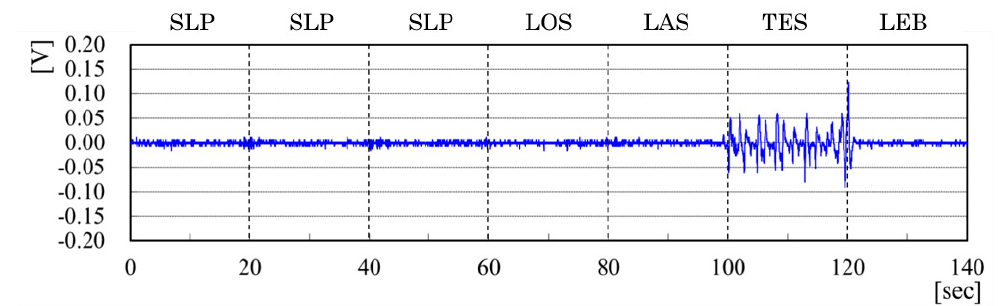
Figure 14. Output signals from rail sensor.